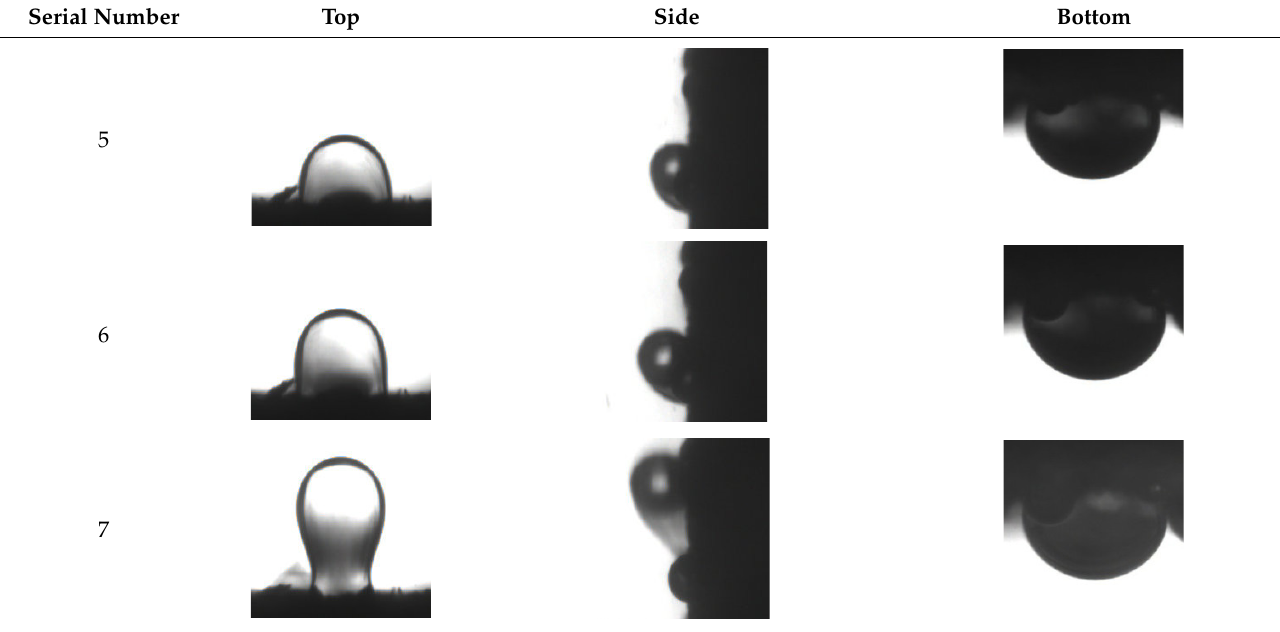
Table 3. Cont. Top Side Bottom